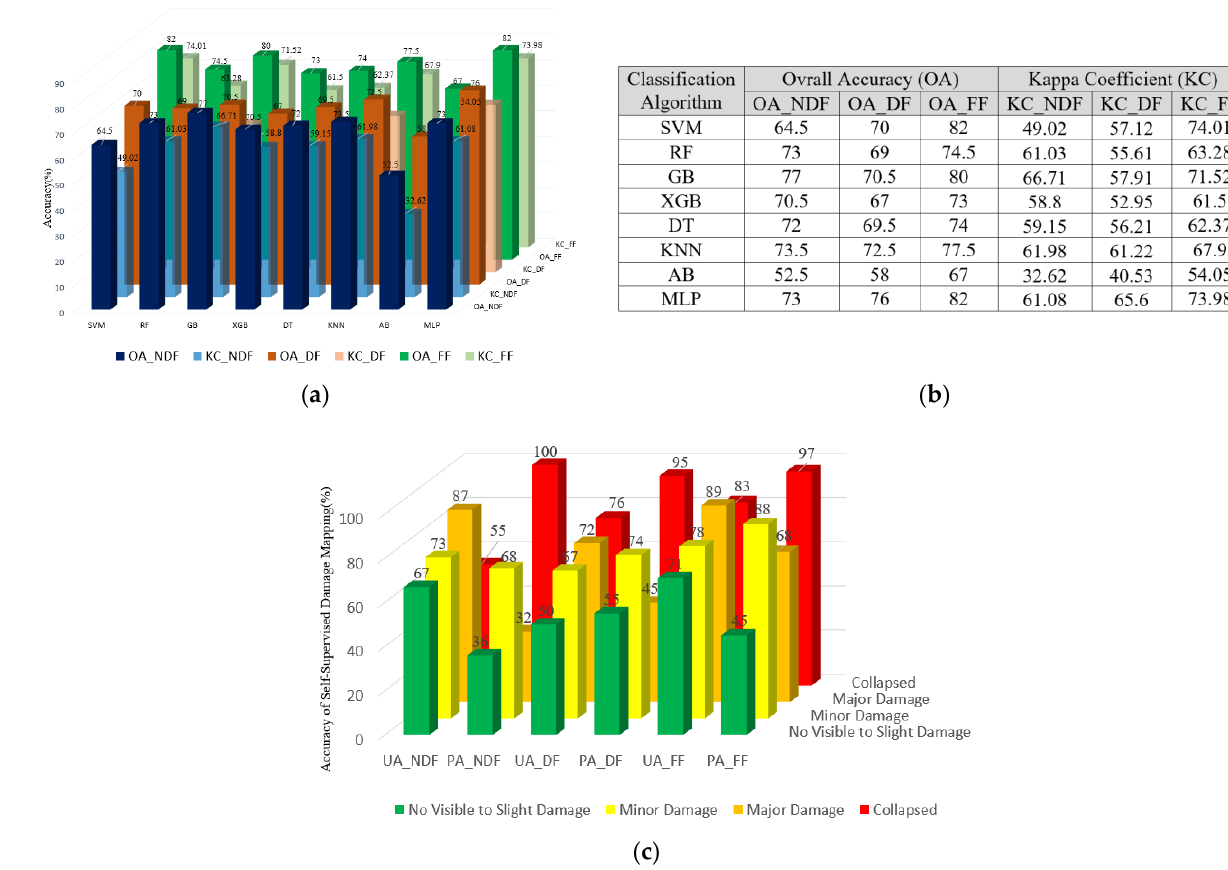
Figure 8. Accuracy assessment of three different feature-extraction approaches along with various types of classification algorithms: ( a , b ) overall accuracy and kappa coefficient, ( c ) user and producer accuracy per damage level for SVM algorithm (the optimal AI method in this case).